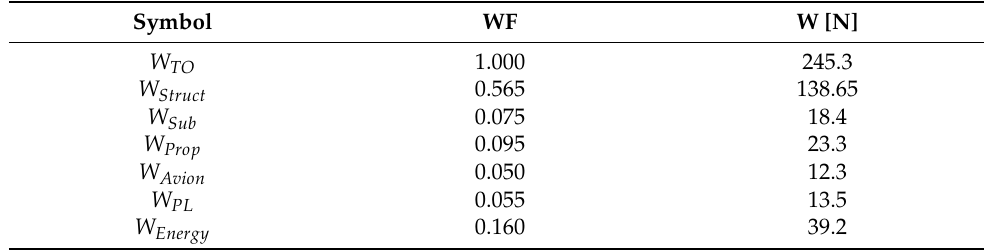
Table 3. Aircraft Initial Weight